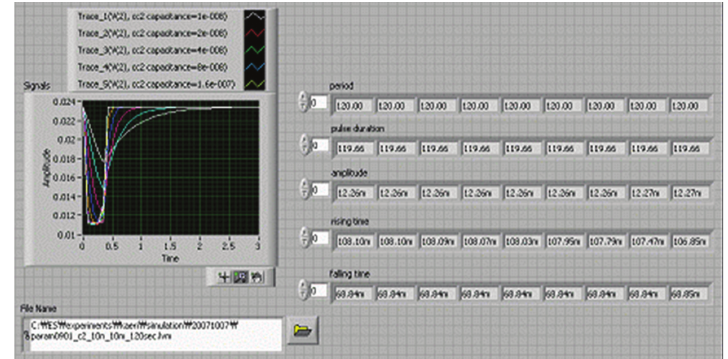
Figure 9: A screen of the ASSA for a one body order simulation